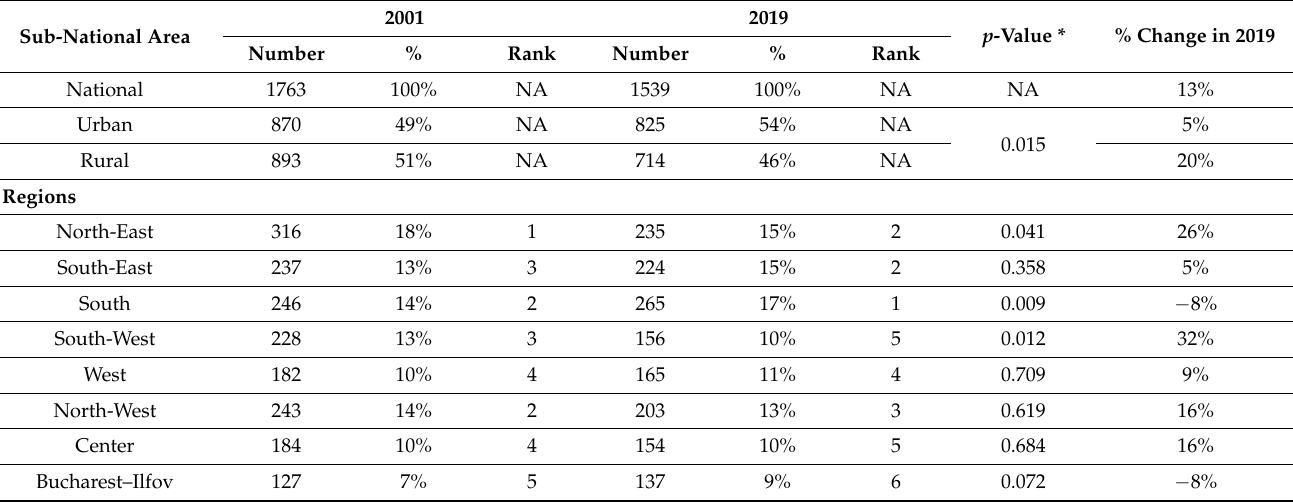
Table 1. Deaths by cervix cancer in Romania, 2001 and 2019, national and subnational distribution and percentage